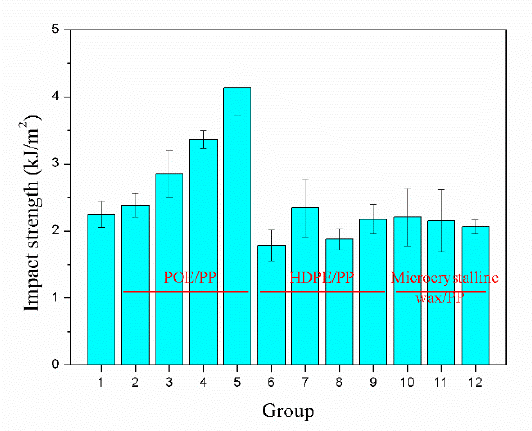
Figure 7. Notched impact strength of the samples with different polymer blends.